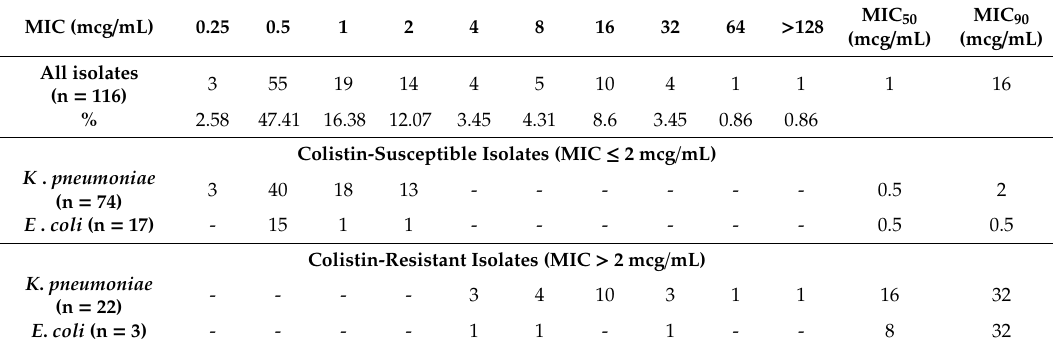
Table 4. Minimum inhibitory concentrations (MICs) distribution of